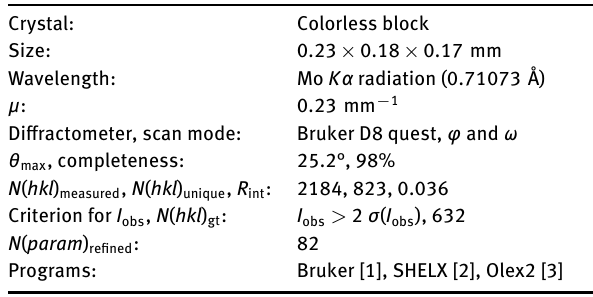
Table 2: Fractional atomic coordinates and isotropic or equivalent isotropic displacement parameters (Å 2